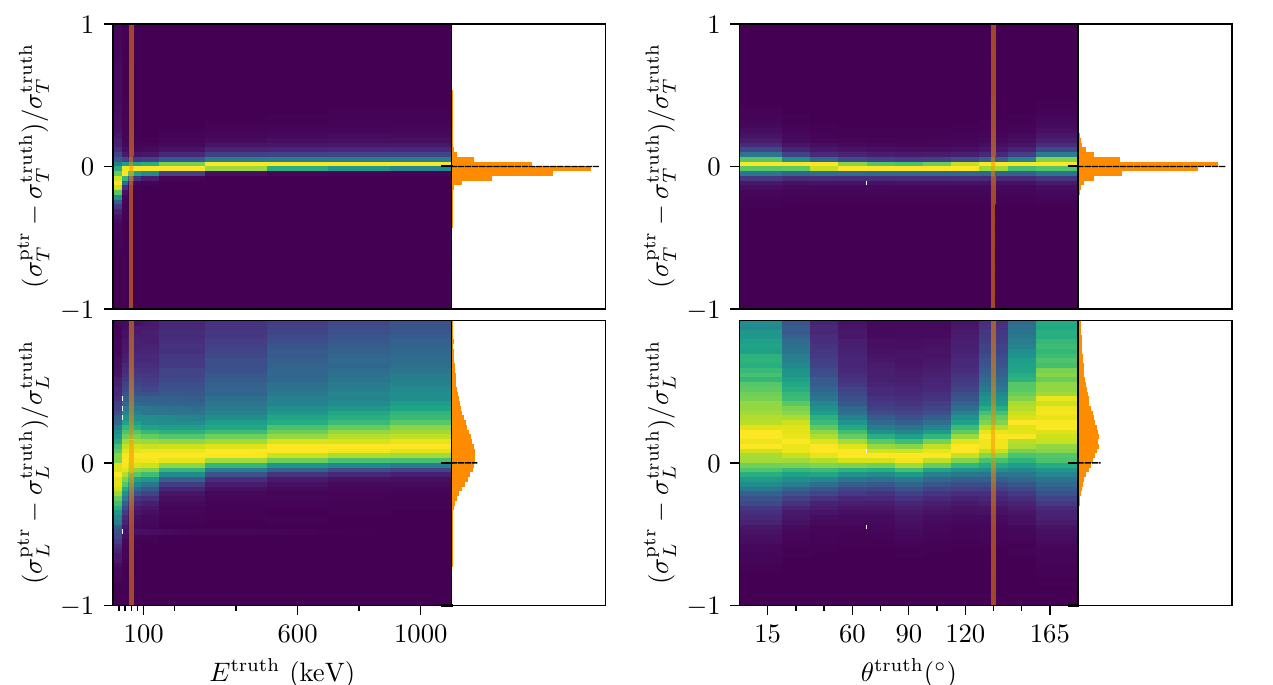
Fig. 10 The fractional error in the widths σ T (top) and σ L (bot- tom), versus primary track energy (left) and polar angle (right). The color/shade indicates the number of events in 2D bins, independently